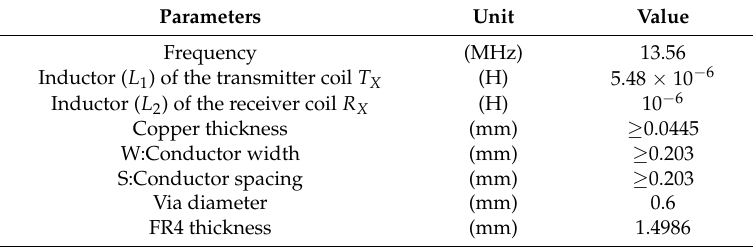
Table 6. parameters limited by the implant and the fabrication technology.